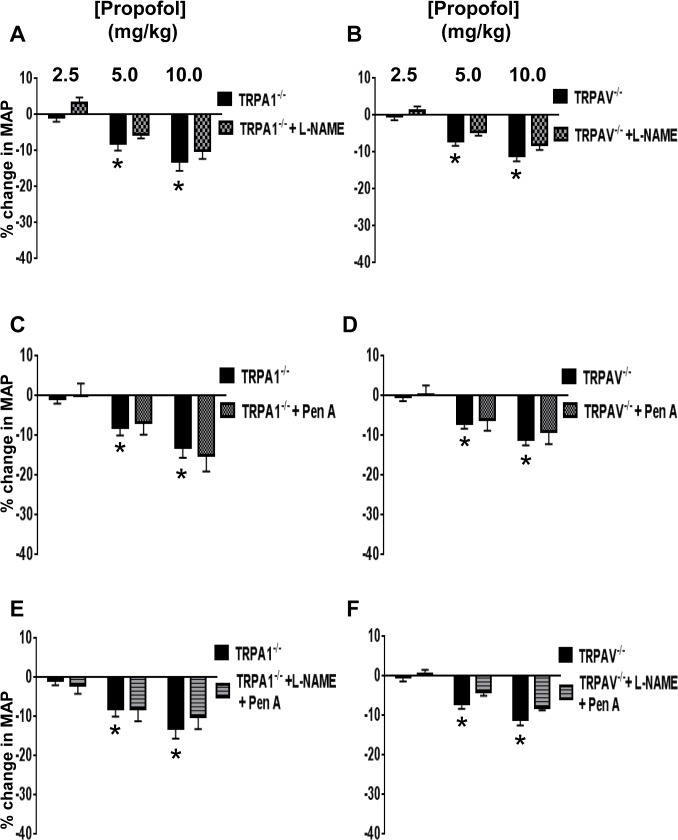
Propofol induced changes in MAP in TRPA1-/- and TRPAV-/- mice: Panels A and B: Summarized data depicting the effect of L-NAME (100 mg/kg/min) on propofol-induced changes in MAP in TRPA1-/- and TRPAV-/- mice.Panels C and D: Summarized data depicting the effect of Pen A (50ug/kg/min) on propofol-induced changes in MAP in TRPA1-/- and TRPAV-/- mice. Panels E and F: Summarized data depicting the effect of L-NAME and Pen A in combination on propofol-induced changes in MAP in control and TRPA1-/- and TRPAV-/- mice. Data are means ± SEM. *P<0.05 compared to baseline. n = 6 mice in each group.